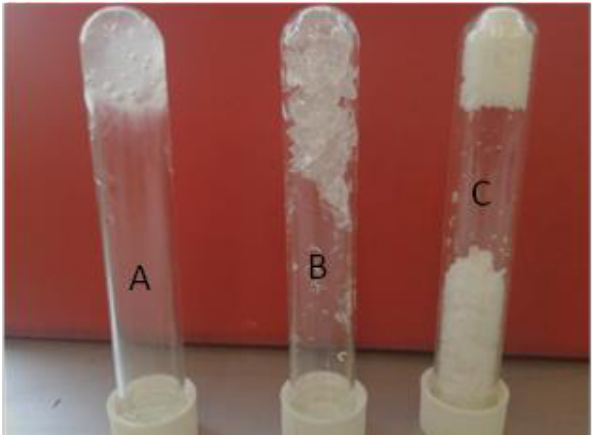
Figure 2. HPMC-based MBGs of different water content. System A: HPMC = 18% w / w , H 2 O = 71% w / w , µE = 11% w / w ; System B: HPMC = 28% w / w , H 2 O = 55% w / w , µE = 17% w / w ; System C: HPMC = 44% w / w , H 2 O = 43% w / w , µ E = 13% w / w . µ E: AOT microemulsion w o = 15. Tubes are reversed to visualize their sticky